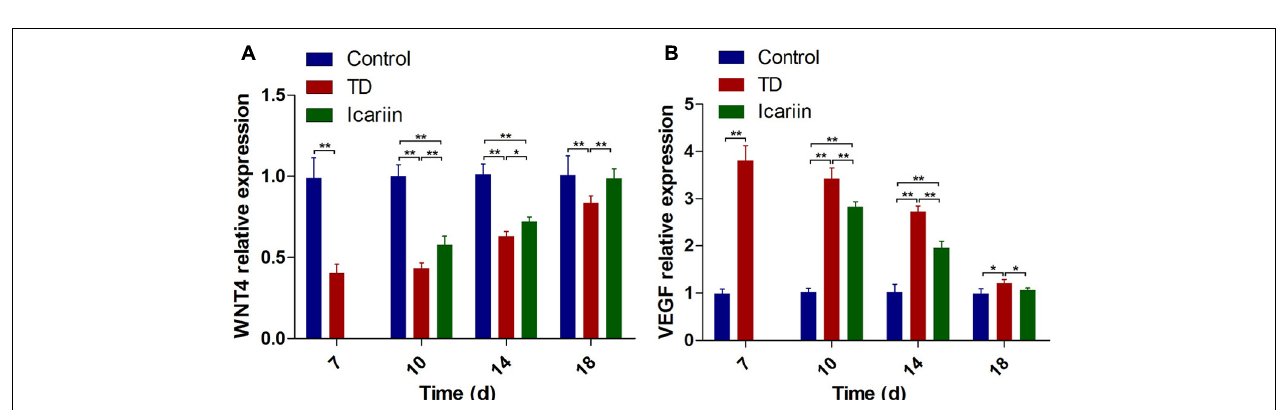
FIGURE 8 | The antioxidant activities analysis of liver in control, TD, and icariin group chickens at 7, 10, 14, and 18 days. The data are presented in mean ± SD. ∗ P < 0.05, ∗∗ P < 0.01.